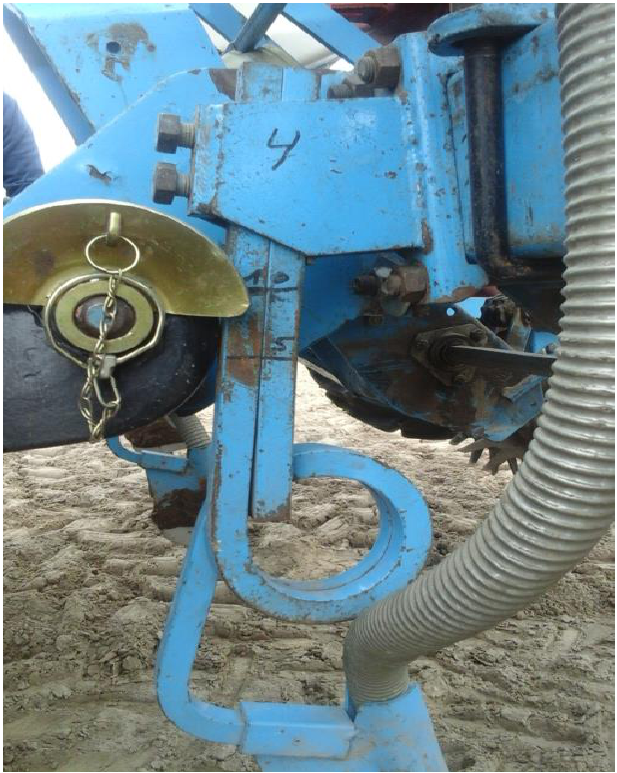
Figure 1. Setting the depth of NP fertilizer placement (photo taken by Szulc P.).